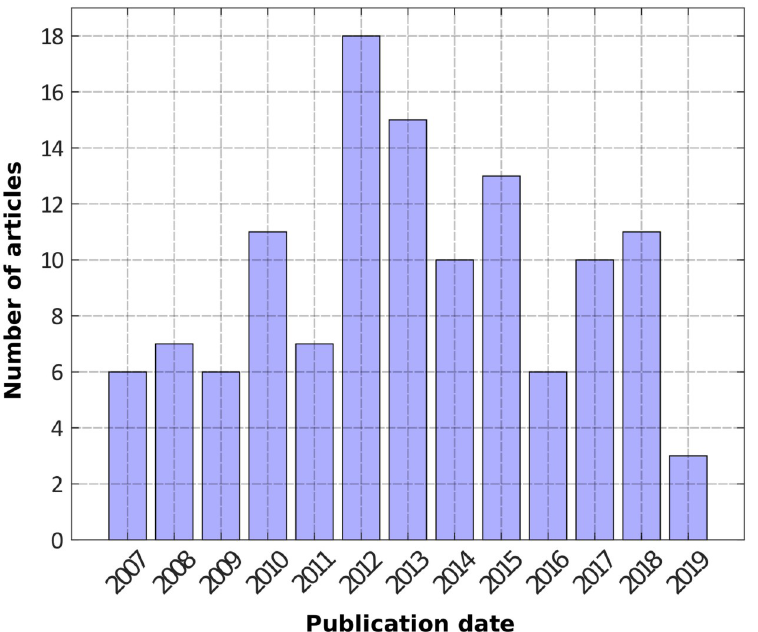
Fig 1. Number of Vigie-Nature articles per year of publication. NB : At the time of our analysis, the whole data for 2019 were not yet available, which explains the relative low number of articles for this year.